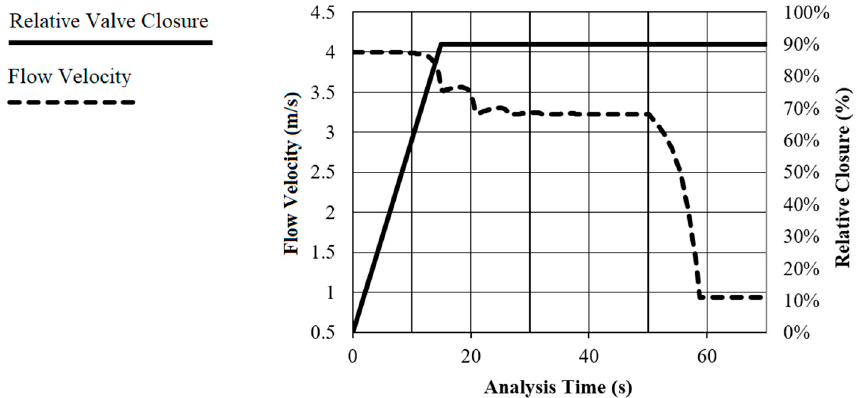
Figure 6. Flow velocity upstream of the valve and relative valve closure.